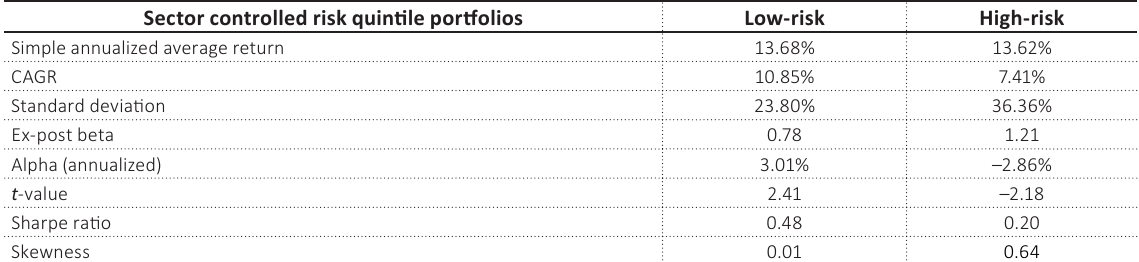
Table 4. Performance of low-risk and high-risk portfolios controlling for sector effect (macro